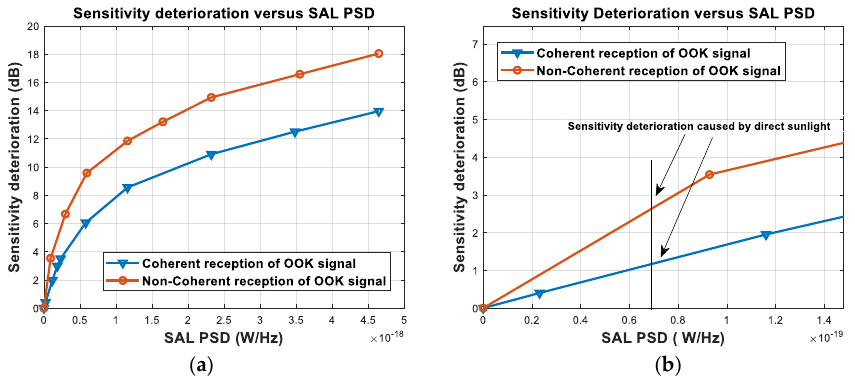
Figure 16. Curves of sensitivity deterioration vs. SAL PSD (( a ) global and ( b ) local). tral wavelength of 1555.74 nm. From the curves of coherent reception and non-coherent reception in Figure 16, it can be concluded that the sunlight power coupled into the re- ceiver SMF caused 1.15 dB sensitivity deterioration to the coherent OOK receiver and 2.60 dB sensitivity deterioration to the non-coherent OOK receiver when the sun shines di- rectly. These results are similar to those reported by Fidler et al. [46]. Thus, the coherent OOK receiving system has better anti-AL noise performance than the non-coherent OOK receiving system, and the coherent and non-coherent OOK receivers requiring SMF cou- pling can both work in direct sunlight.